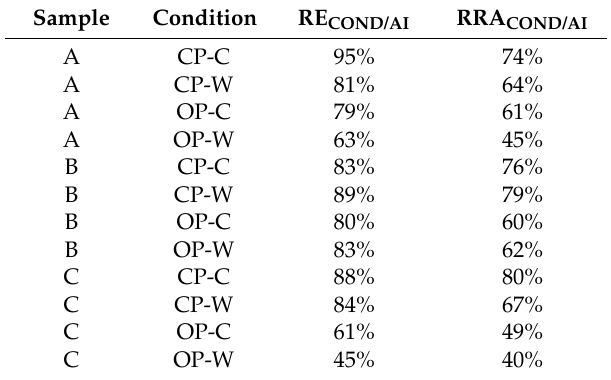
Table 6. Hydrogen Embrittlement (HE) assessment ratios for the underwater cathodically protected testing.